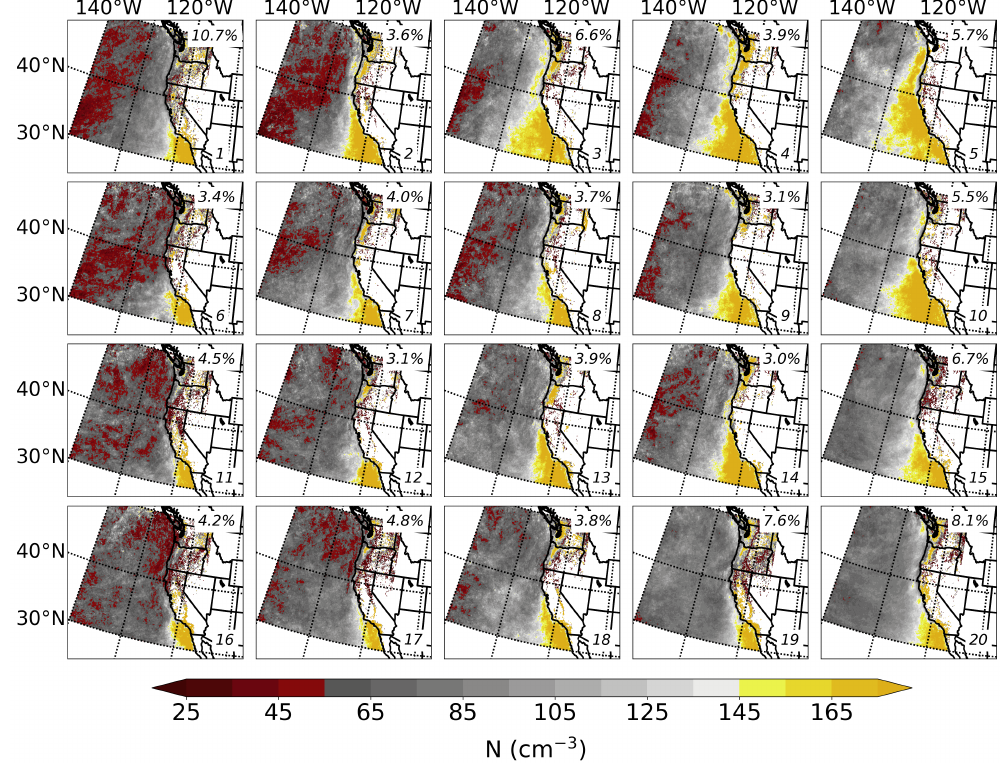
Figure 5. MODIS estimation of N (contoured every 10cm − 3 according to the color bar) for each node in the 4 × 5 SOM topology. Each panel represents the mean conditions for each node (number displayed in the bottom right corner), while the percentage frequency of occurrence is displayed in the top right